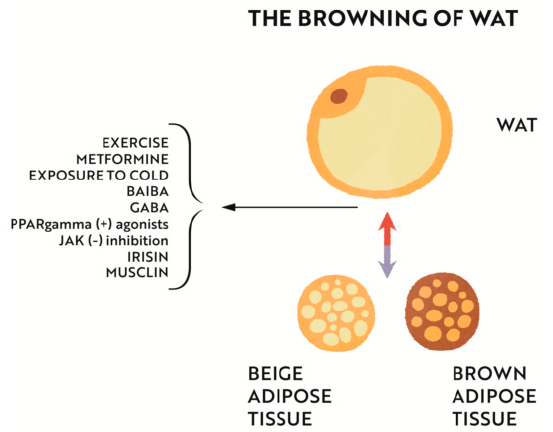
Figure 4. Browning of WAT can be caused by: exercise, exposure to cold, metformin, beta-aminoisobutyric acid (BAIBA), gamma-aminobutyric acid (GABA), PPAR-gamma agonists, Janus Kinase (JAK) inhibition, and irisin.